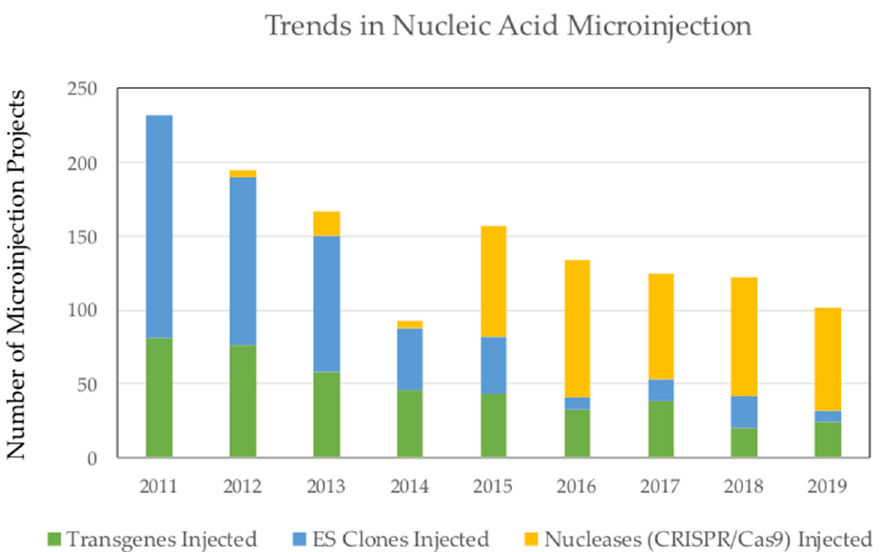
Figure 1. Recent trends in nucleic acid microinjection in zygotes, and embryonic stem (ES) cell microinjections into blastocysts, for the production of genetically engineered mice at the University of Michigan Transgenic Core. As shown, prior to the introduction of CRISPR / Cas9, the majority of injections were of ES cells, to produce gene-targeted mice, and DNA transgenes, to produce transgenic mice. After CRISPR / Cas9 became available, adoption was slow until 2014, when it was enthusiastically embraced, and the new technology corresponded to a reduced demand for ES cell and DNA microinjections.